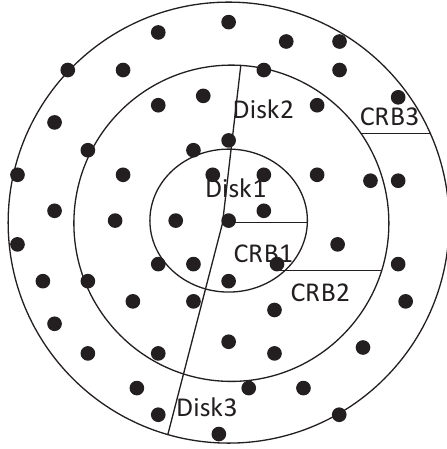
Figure 2. Formation of CRB and Disks in EDS.